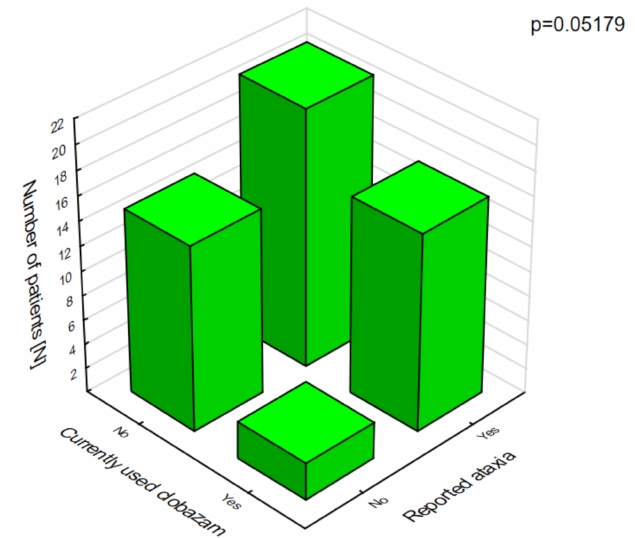
Figure 9. Clobazam and ataxia.